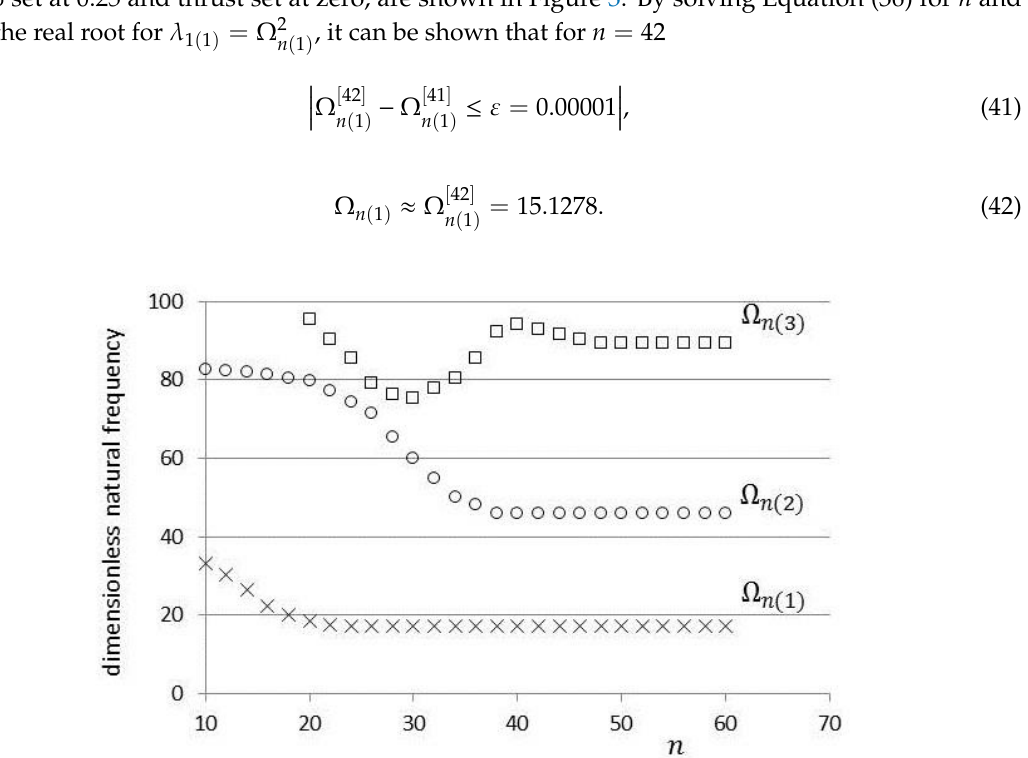
Figure 3. Convergence plots for the first three dimensionless natural frequencies when β = 0.25 .